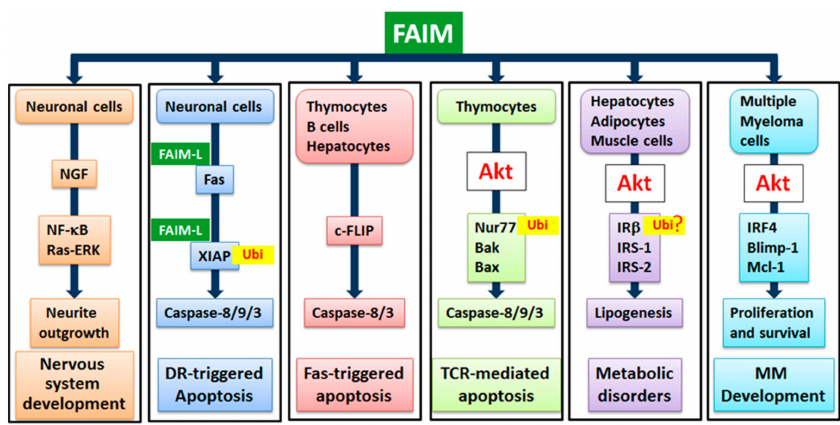
Figure 2. Schematic representation of FAIM’s involvement in various signaling pathways and physiological or disease